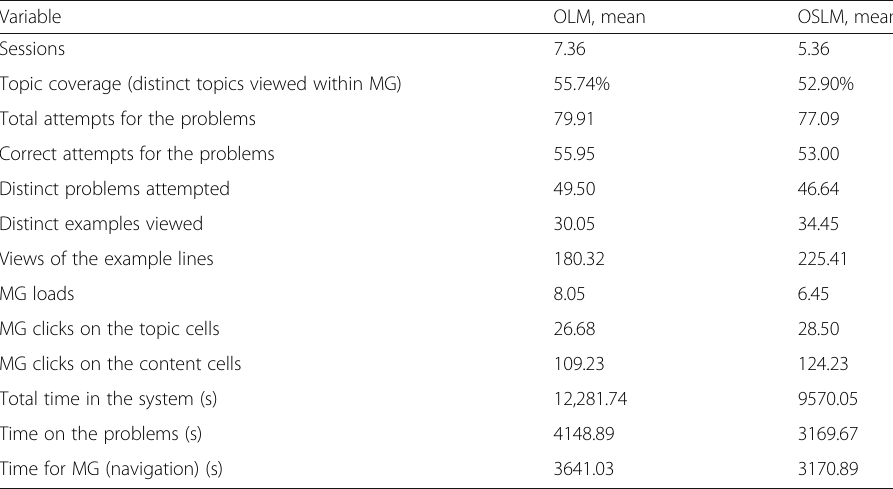
Table 3 System usage by the OLM and OSLM groups in study 1 Variable OLM, mean OSLM, mean Sessions 7.36 5.36 Topic coverage (distinct topics viewed within MG) 55.74% Total attempts for the problems 79.91 Correct attempts for the problems 55.95 Distinct problems attempted Distinct examples viewed Views of the example lines MG loads MG clicks on the topic cells MG clicks on the content cells Total time in the system (s) Time on the problems (s) Time for MG (navigation)